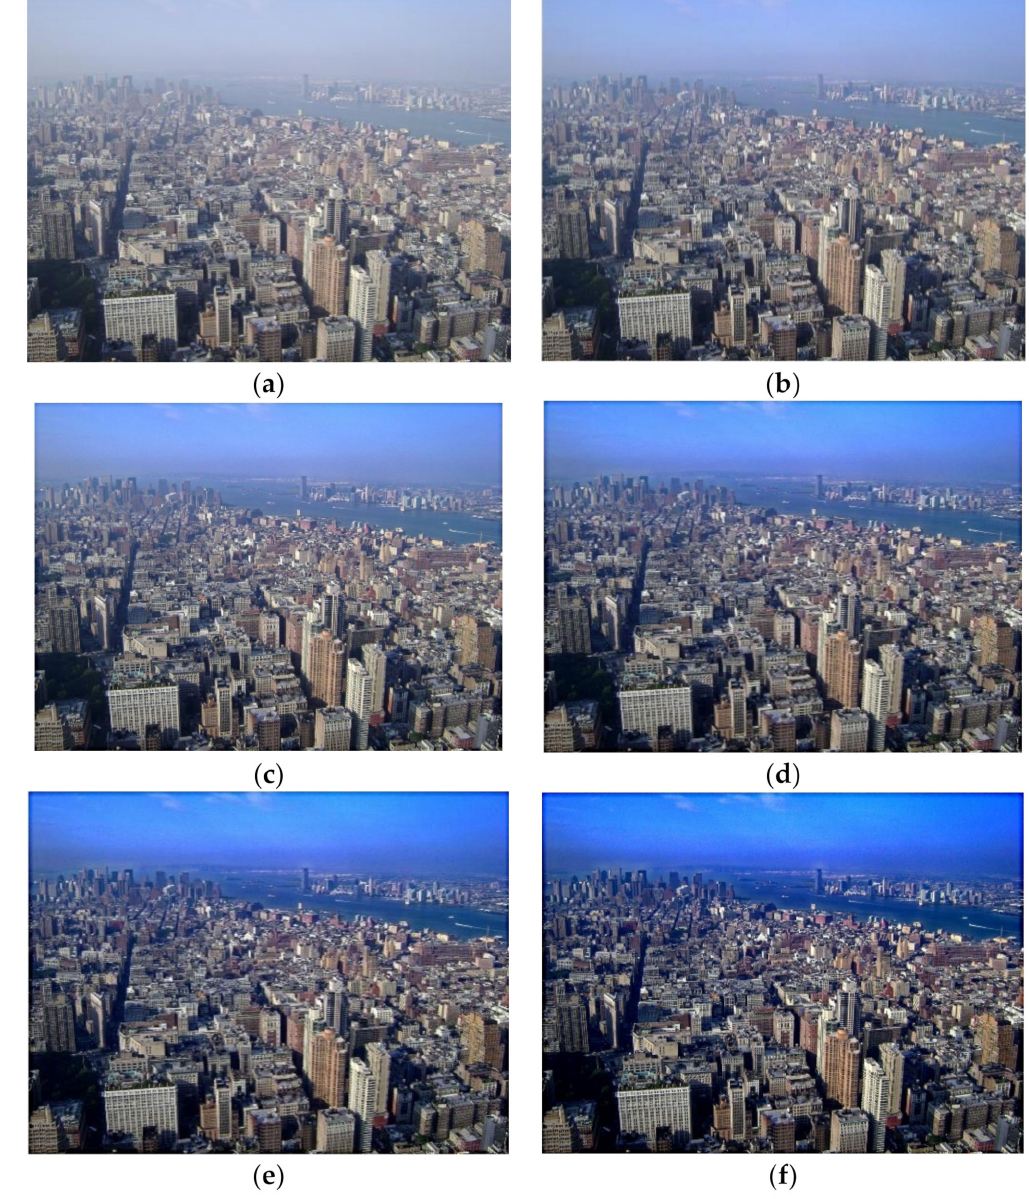
Figure 10. ( a ) original foggy image; ( b ) p = 1, q = 0; ( c ) p = 0.75, q = 0.25; ( d ) p = 0.5, q = 0.5; ( e ) p = 0.25, q = 0.75; ( f ) p = 0, q =